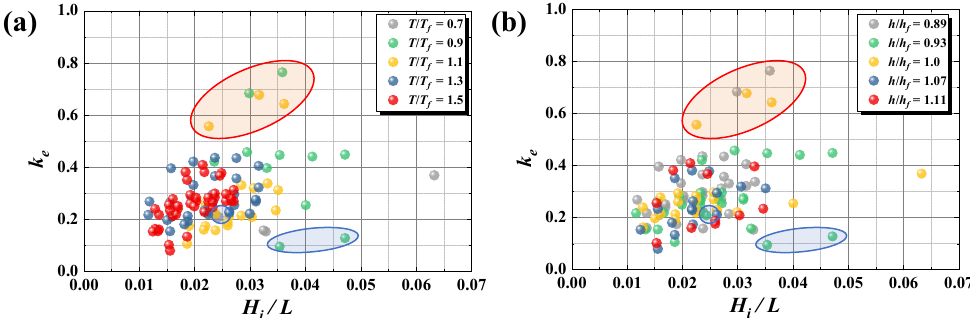
Figure 15. Relationship between k e and H i / L depending on ( a ) T / T f , and ( b ) h / h f .